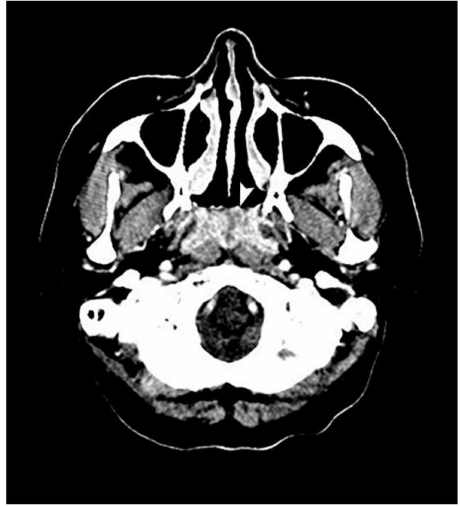
Figure 2. An axial view of a computed tomography scan reveals a mass, indicated by a white arrow, in the entire nasopharynx with ill-defined margins and heterogenous enhancement but that did not extend to the lateral pharyngeal